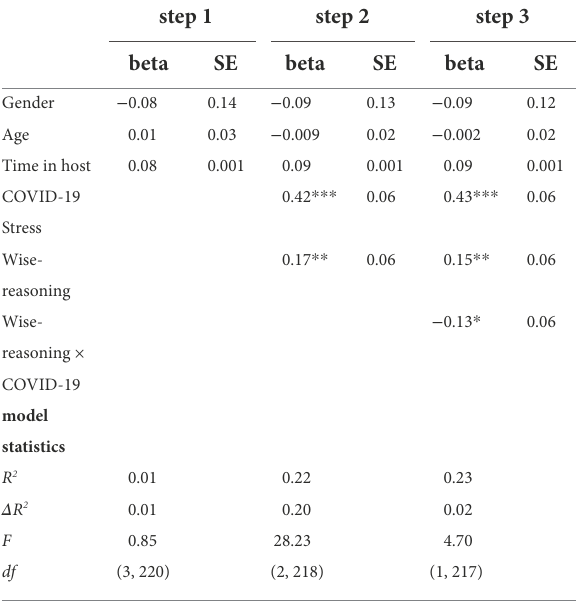
TABLE 2 The moderating effect of wise reasoning on the relationship between COVID-19 stress and